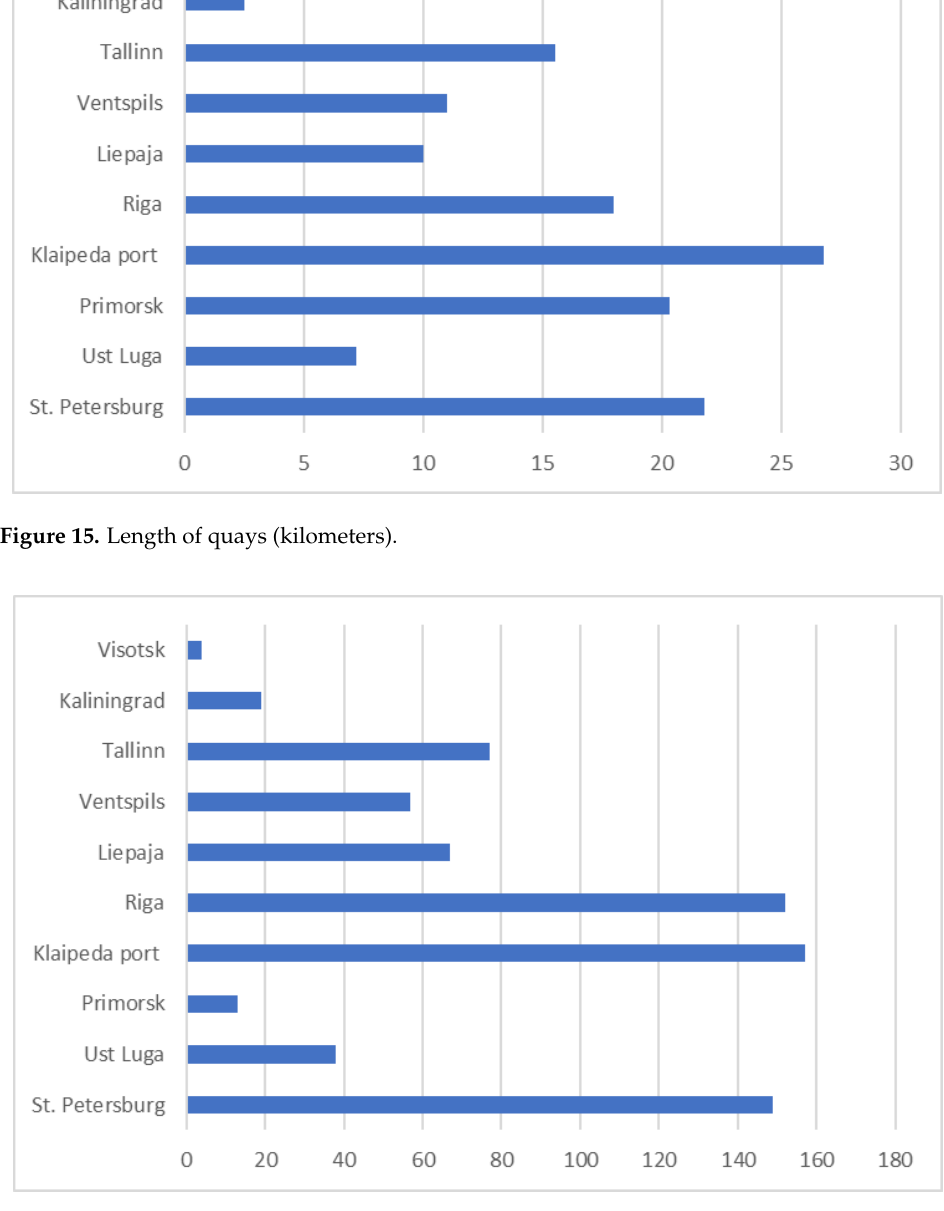
Figure 16. Number of berths (units).